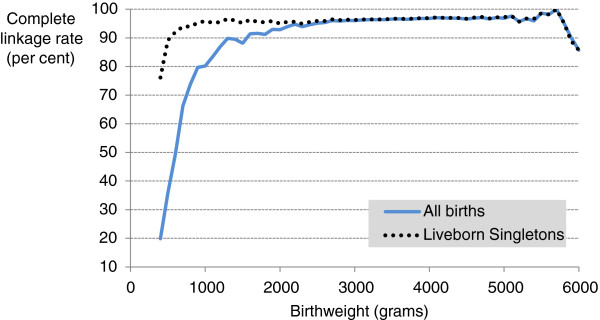
Linkage rate for complete group by birth weight (grams). Complete linkage rate (number of birth records linked to both a mother and infant hospital admission birth record as a percentage of all birth records) by birthweight for all births (blue line) and liveborn singletons (dotted black line).